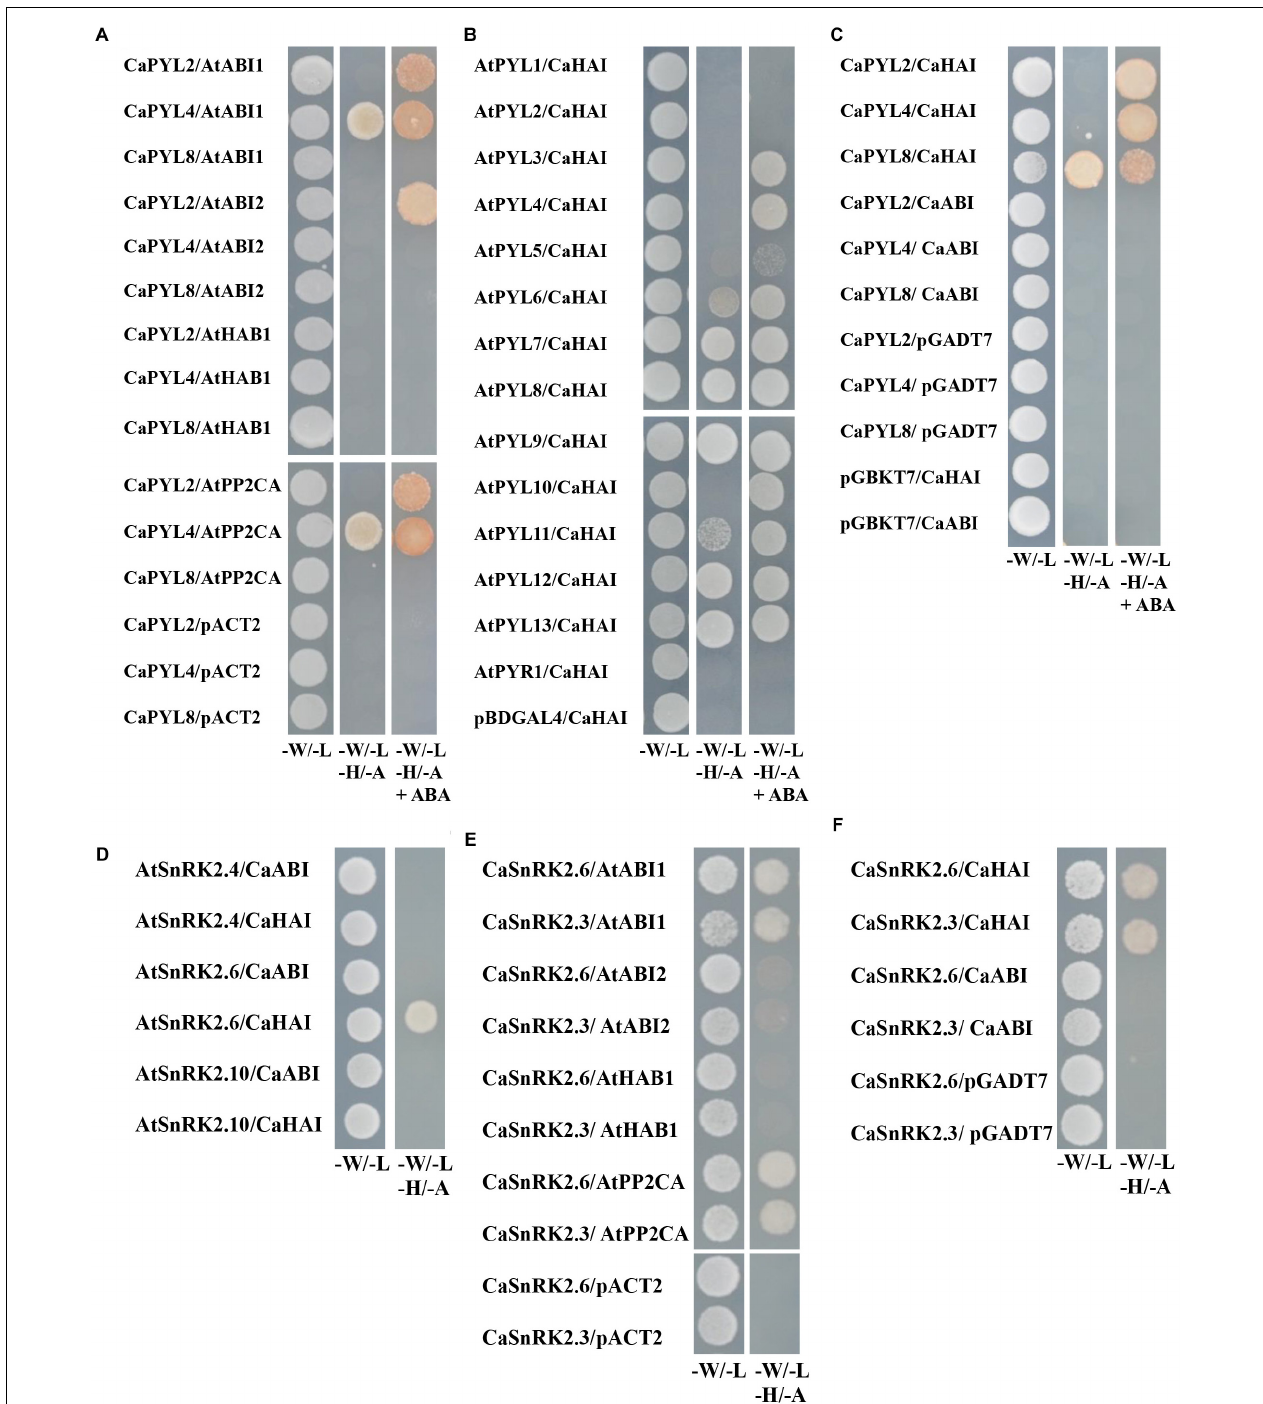
FIGURE 5 | Interaction test of PP2Cs with PYLs and SnRK2s in the yeast two-hybrid assay. (A) AtPP2Cs fused to the GAL4 Activation Domain (AD) were co-transformed in yeast with CaPYLs cloned in frame with the GAL4 binding domain (BD) of pGBKT7, with combinations shown in figure. (B) CaHAI fused to the AD in pGADT7 was expressed in yeast with AtPYLs in pBDGAL4, the different combinations are shown. (C) CaPP2Cs were fused to the AD in pGADT7 and co-transformed with CaPYLs cloned in pGBKT7. (D) CaPP2Cs in pGADT7 were co-transformed in combination with AtSnRK2s cloned in pGBKT7. (E) AtPP2Cs in pACT2 were co-transformed in yeast with CaSnRK2s in pGBKT7, with combinations shown in figure. (F) Co-transformants of yeast containing CaPP2Cs fused to the AD in pGADT7 in combination with CaSnRK2s in pGBKT7. Co-transformations of the pepper PYL/SnRK2/PP2C orthologs with appropriate complementary empty vectors are shown as negative controls. Yeast cells grown on synthetic media (–W/–L) and on synthetic, selective media without (–W/–L/–H/–A) or, where indicated, with 50 µ M ABA (–W/–L/–H/–A+ABA) are shown. Pictures were taken after 3 days of incubation at 30 ◦ C.